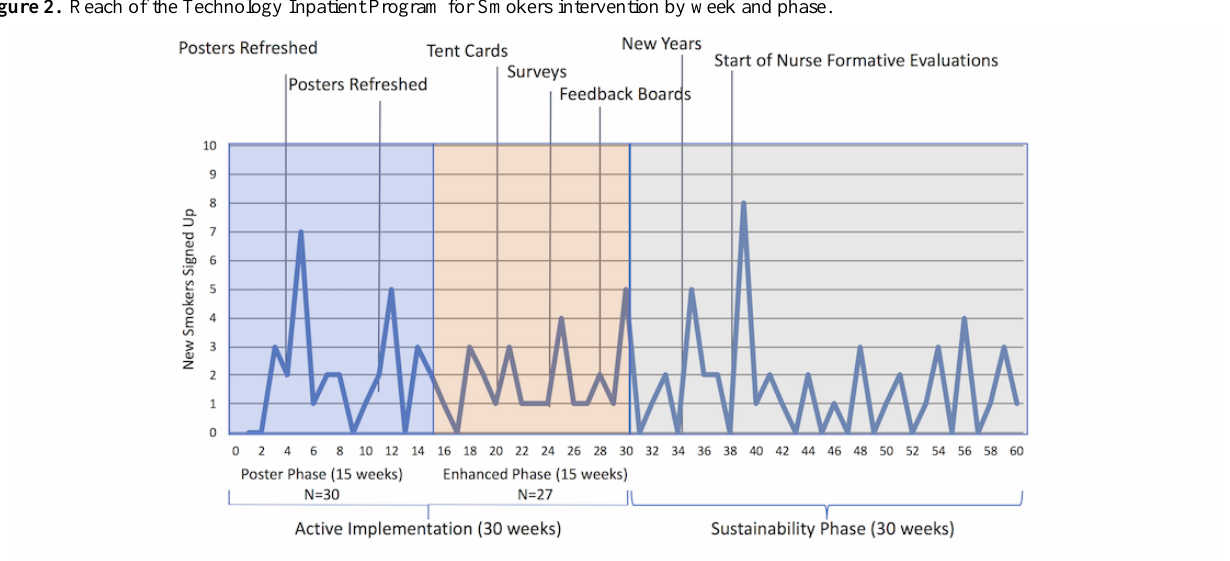
Figure 2. Reach of the Technology Inpatient Program for Smokers intervention by week and